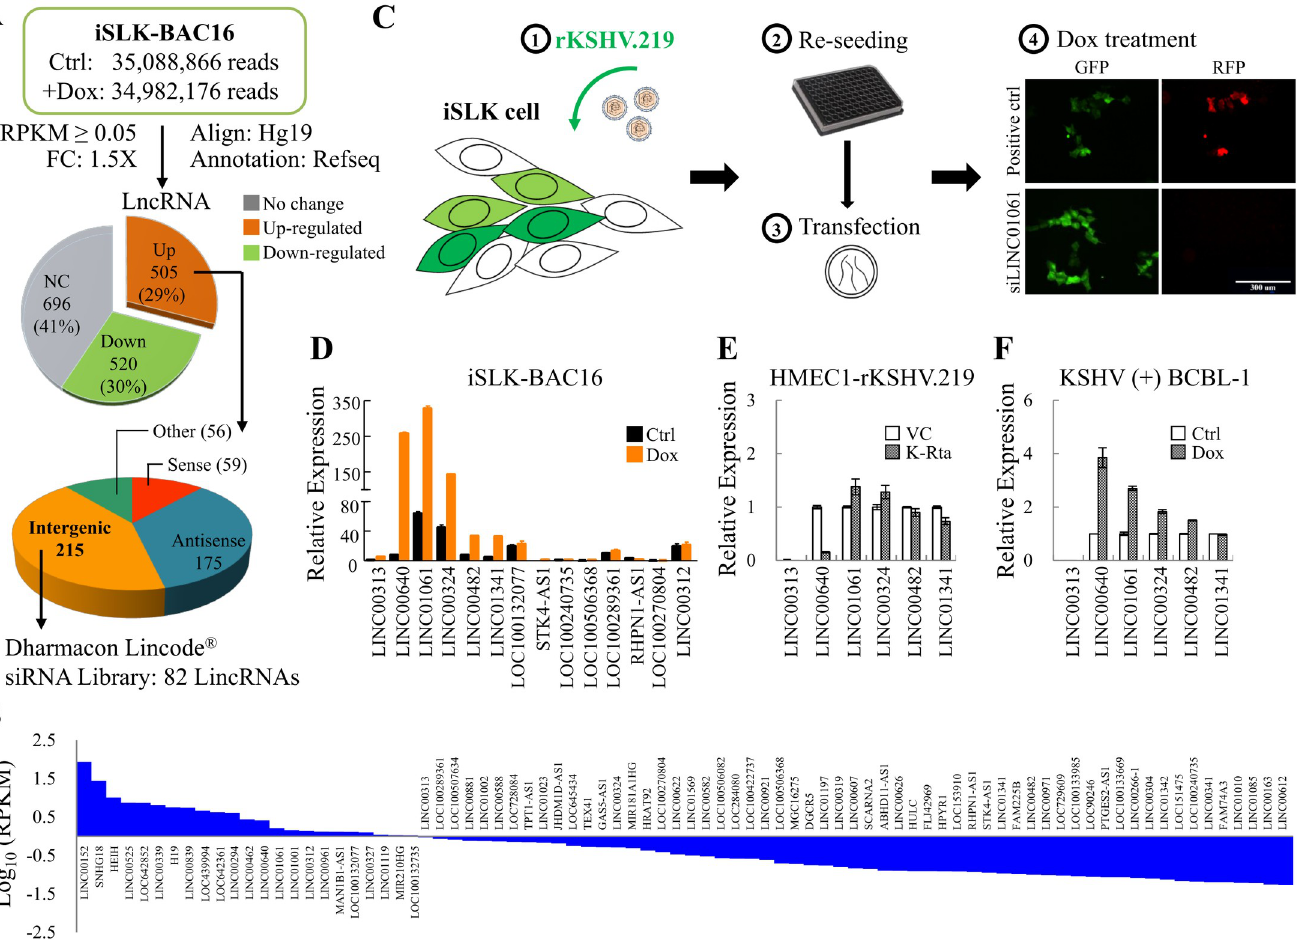
Fig 1. Transcriptome analysis and siRNA knockdown screening of KSHV reactivation-induced lncRNAs essential for KSHV latent-to-lytic switch. (A) Workflow showing the identification of KSHV reactivation-induced long intergenic non-coding RNAs (LincRNAs). RNA-seq was performed using total RNA isolated from iSLK-BAC16 cells treated with and without Dox for 24 hours. Paired-end raw reads were aligned to human reference genome hg19 using CLC Genomics Workbench (Qiagen Germantown, MD, USA) and annotated to Refseq using Partek Genomics Suite (Partek, MO, USA). Reads per kilobase of transcript per million mapped read (RPKM) higher than 0.05 in at least one condition was considered as expressed and used for analysis. Pie chart (Top) showing the numbers (percentages) of long non-coding RNAs (LncRNAs) that were up- or down-regulated more than 1.5-fold after Dox induction for viral reactivation. Pie chart (Bottom) showing the numbers of different types of up-regulated lncRNAs. (B) Histogram demonstrating the expression (RPKM, log10 scale) of 82 KSHV reactivation up-regulated lincRNAs present in the siRNA Library (Dharmacon, GU-301000). (C) Schematic representing the siRNA screening procedure of lincRNAs that mediate KSHV reactivation. The recombinant KSHV, rKSHV.219, produced from Vero-rKSHV.219 cells were used to infect iSLK cells. After 24 hours, iSLK-rKSHV.219 cells were re-seeded in 96-well-plates at a density of 1000 cells/well. Cells were attached overnight and transfected with siRNAs. Eighteen hours after transfection, cells were treated with 2 μ g/ml Dox for another 72 hours, fixed by 4% paraformaldehyde, stained with Hochest 33258. The GFP and RFP positive cells were observed with an inverted fluorescence microscope. Representative images (100x magnification) of iSLK-rKSHV.219 cells transfected with siLINC01061 was shown. Cells without siRNA transfection was used as positive control. Scale bar: 300 μ m. (D) RT-qPCR analysis of the expression of 14 lincRNAs identified in Fig 1C in iSLK-BAC16 cells treated with 1 μ g/ml Dox for 24 hours. The expression of lincRNAs was normalized to GAPDH and the relative expression of LINC00313 in iSLK-BAC16 cells (Ctrl) was considered to be 1. (E) rKSHV.219 was used to infect HMEC1 cells, followed by transient puromycin selection for a week. After selection, HMEC1-rKSHV.219 cells were re-seeded in 6-well-plates. Cells were attached overnight and transduced with lentiviruses harboring pLenti4-Flag-K-Rta or empty vector control (VC). 72 hours after transduction, total RNA was collected, followed by RT-qPCR analysis of the expression of 6 lincRNAs that were up-regulated in iSLK-BAC16 after viral reactivation. The expression of lincRNAs was normalized to GAPDH and reported as the relative expression of vector control (VC = 1). (F) RT-qPCR analysis of the expression of 6 lincRNAs identified in Fig 1D in TREx-F3H3-K-Rta BCBL-1 cells treated with 0.2 μ g/ml Dox for 72 hours. The expression of lincRNAs was normalized to GAPDH and plotted as the relative expression versus non-induced cell Ctrl (Ctrl = 1).